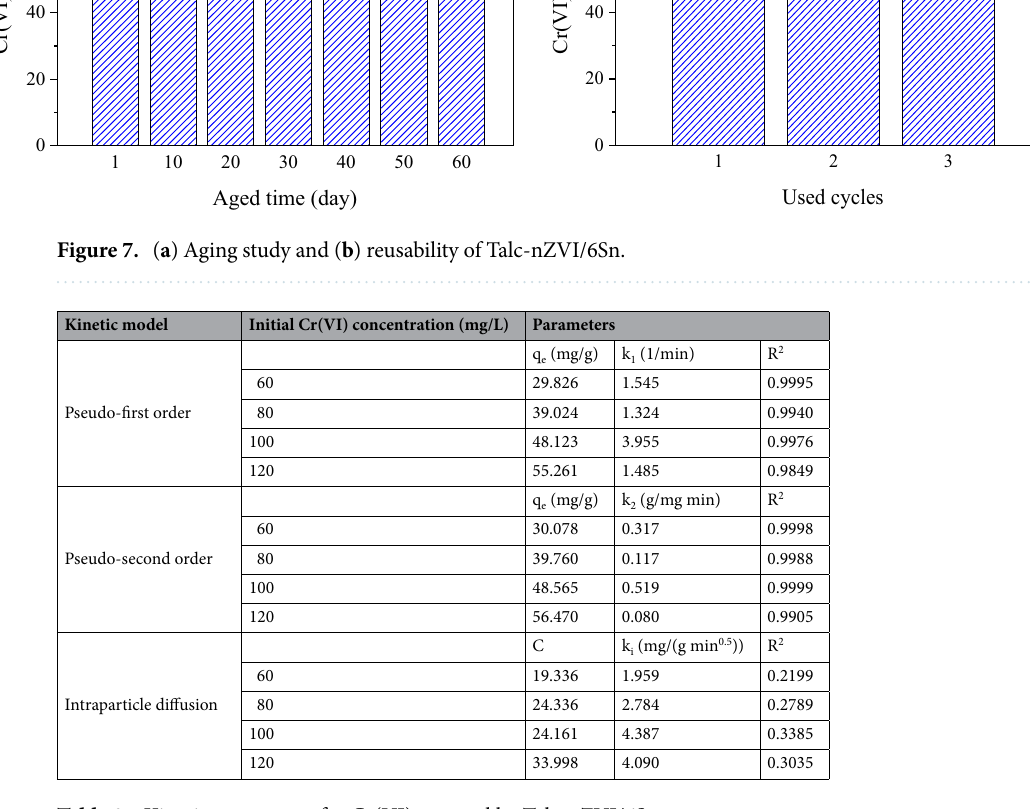
Table 2. Kinetic parameters for Cr(VI) removal by Talc-nZVI/6Sn.